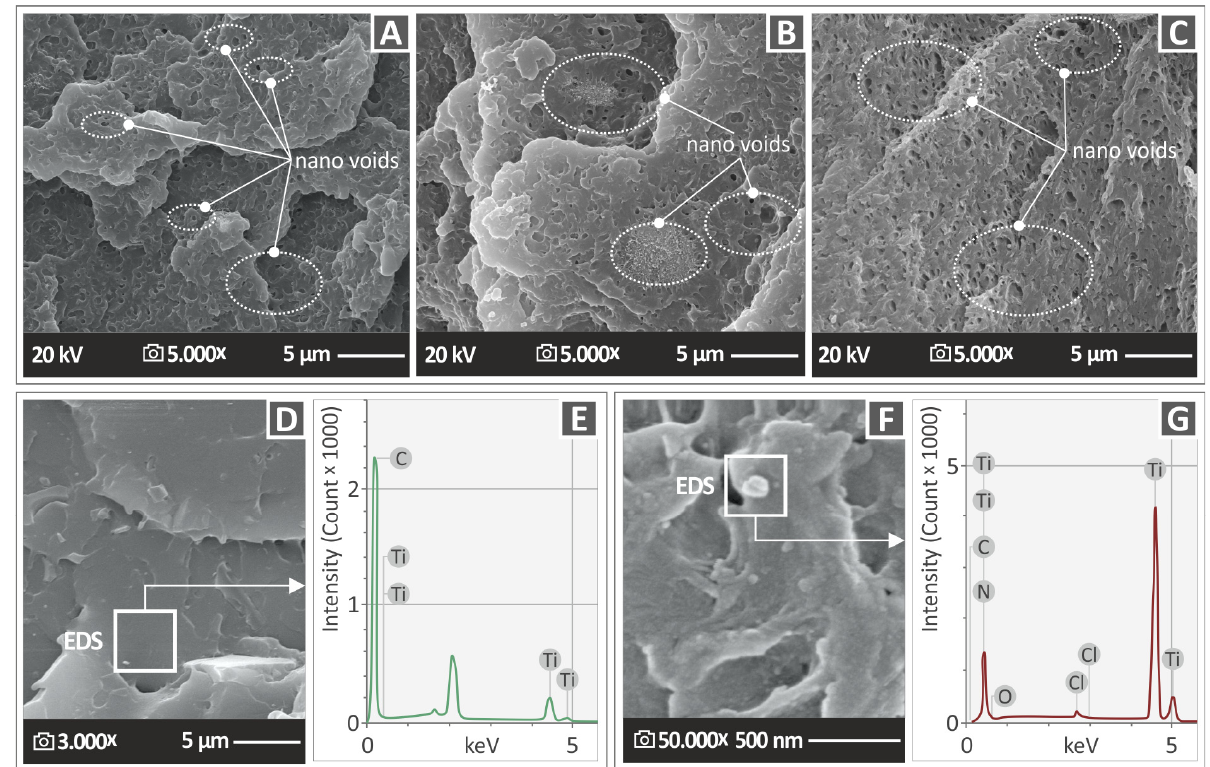
Figure 14. Fracture surface SEM images of specimens at 5000× magnification for ( A ) ABS/TiN 1 wt. % ( B ) ABS/TiN 4 wt. %, ( C ) ABS/TiN 6 wt. %. ( D ) ABS/TiN 6 wt. % at 3000× magnification and ( E ) EDS analysis of ABS/TiN 6 wt. % obtained on a random region of the side surface image. ( F ) ABS/TiN 8 wt. % at 50,000× magnification and ( G ) EDS analysis for ABS/TiN 8 wt. % obtained on a TiN nanoparticle-rich region.